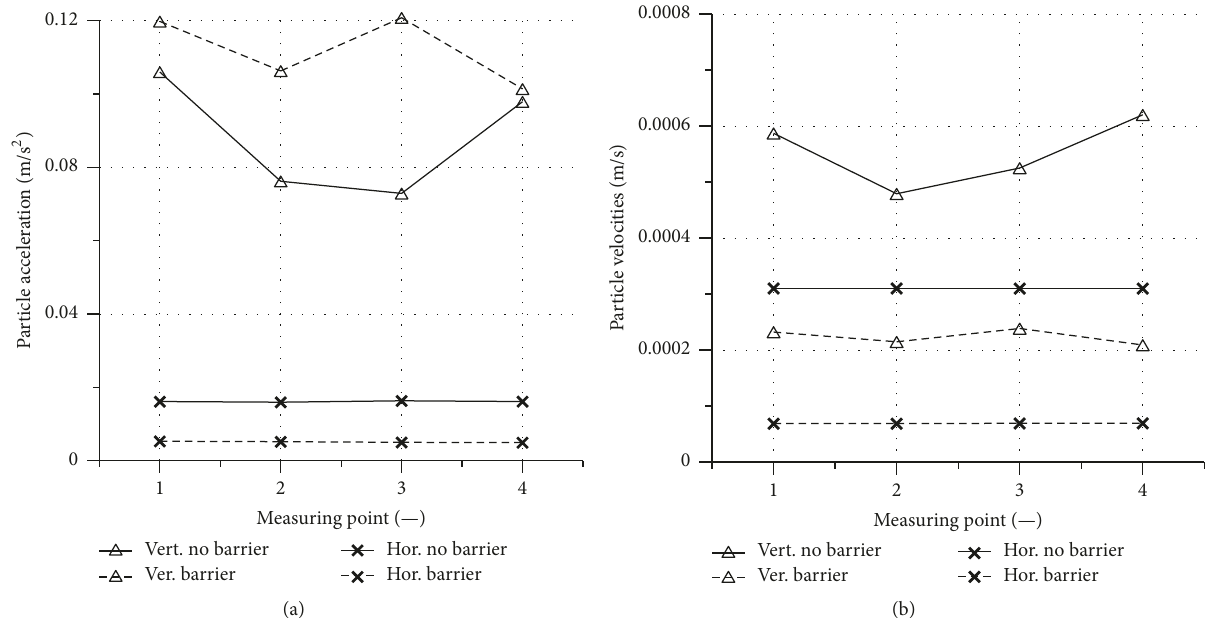
Figure 12: Maximum particle velocities and acceleration on several points of the foundation slab with (dashed line) and without (solid line) a wave